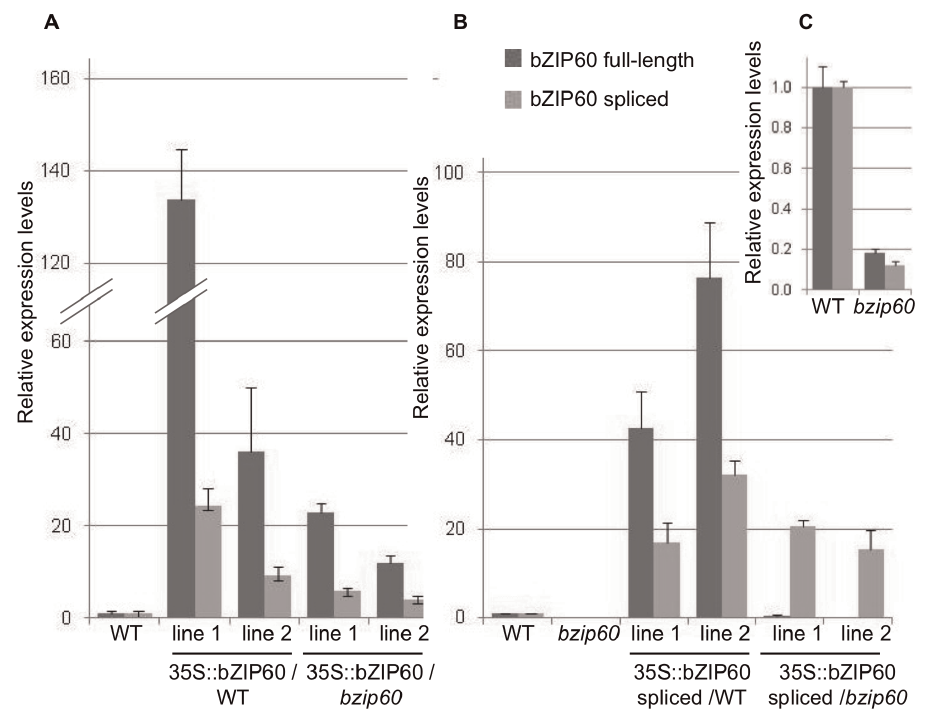
Figure 1. Expression of bZIP60 transcript variants in transgenic and mutant lines. Quantification by qRT-PCR of bZIP60 transcript variants relative to the Ubiquitin 5 reference gene in 8 d-old seedlings in lines over-expressing the full-length transcript (A) and in lines over-expressing the spliced version (B) in WT and bzip60 mutant backgrounds. Graph C is a close-up view of the graph in B showing expression levels in bzip60 mutant compared to WT. Two independent lines are shown for each transformed construct. Error bars=SE.